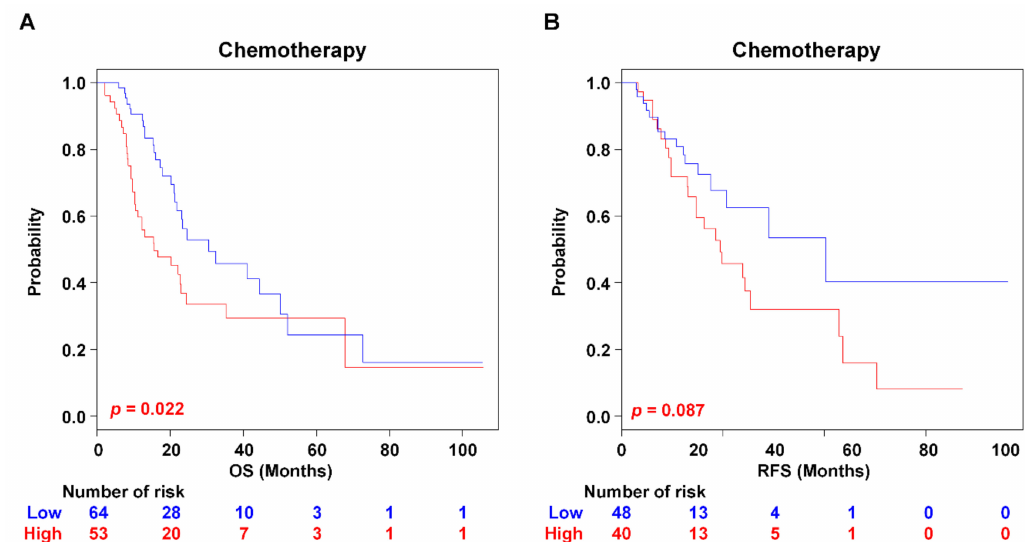
Figure 5. Kaplan–Meier survival analysis of PAC patients with chemotherapy. The patients were separated into risk-subgroups according to chemotherapy treatment. Kaplan–Meir analyses were used to evaluate the therapeutic advantage. ( A ) Kaplan–Meier plots for OS of two risk-subgroups. ( B ) Kaplan–Meier plots for RFS of two risk-subgroups. p -Values were computed by the log-rank